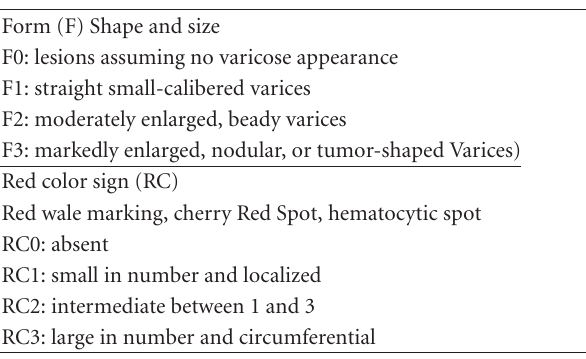
Table 1: General rules for recording endoscopic findings of esophagogastric varices, as published by the Japanese Society for Portal Hypertension (2004) [16].